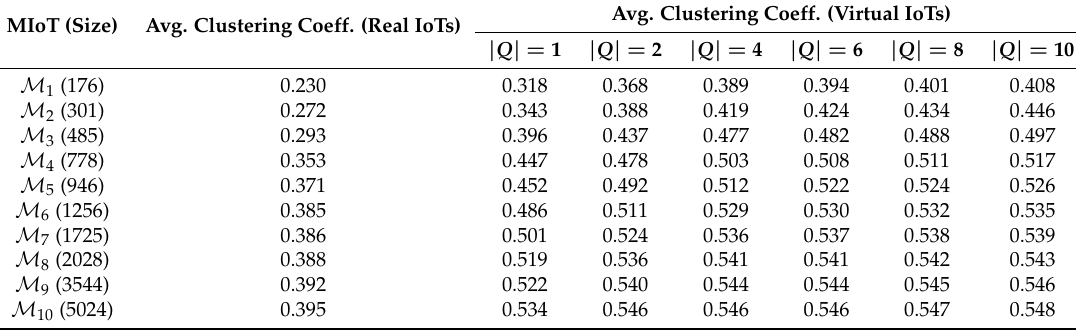
Table 2. Values of the clustering coefficient for real and virtual IoTs against the size of MIoTs and queries used to generate the virtual IoTs (supervised approach).